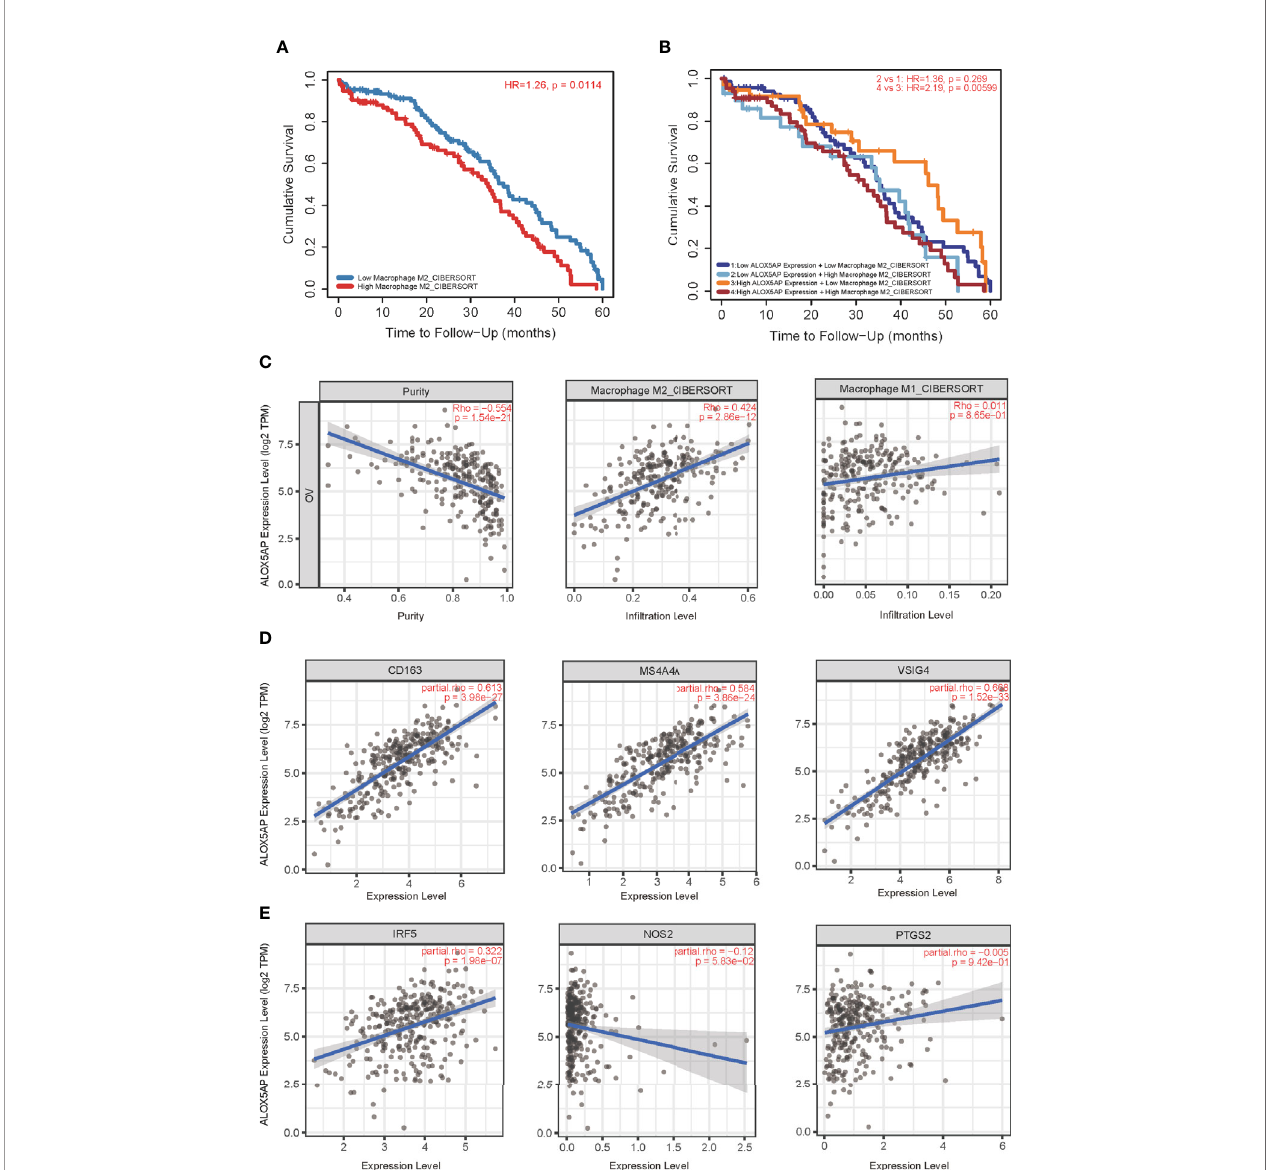
FIGURE 7 | Correlation of ALOX5AP expression and M2 macrophages polarization. (A) Survival analysis of patients with high or low M2 macrophage in fi ltration in TCGA-OV cohort. (B) Survival time comparation in groups of different ALOX5AP expression and M2 macrophage in fi ltration. (C) Purity ‐ corrected Spearman ’ s correlation between ALOX5AP expression in ovarian cancer and two types of macrophages in fi ltration. The correlation between ALOX5AP and molecular biomarkers of (D) M2 macrophages and (E) M1